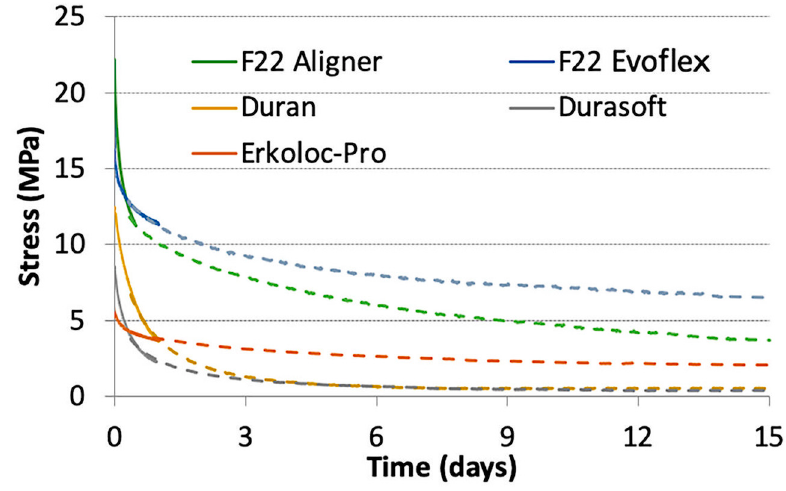
Figure 5. Stress relaxation curves.